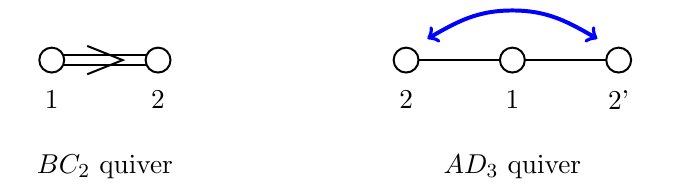
Figure 1 . From AD 3 to BC 2 by folding (identifying) the nodes i = 2 and 2’. The direction of the doubled arrow is from long to short